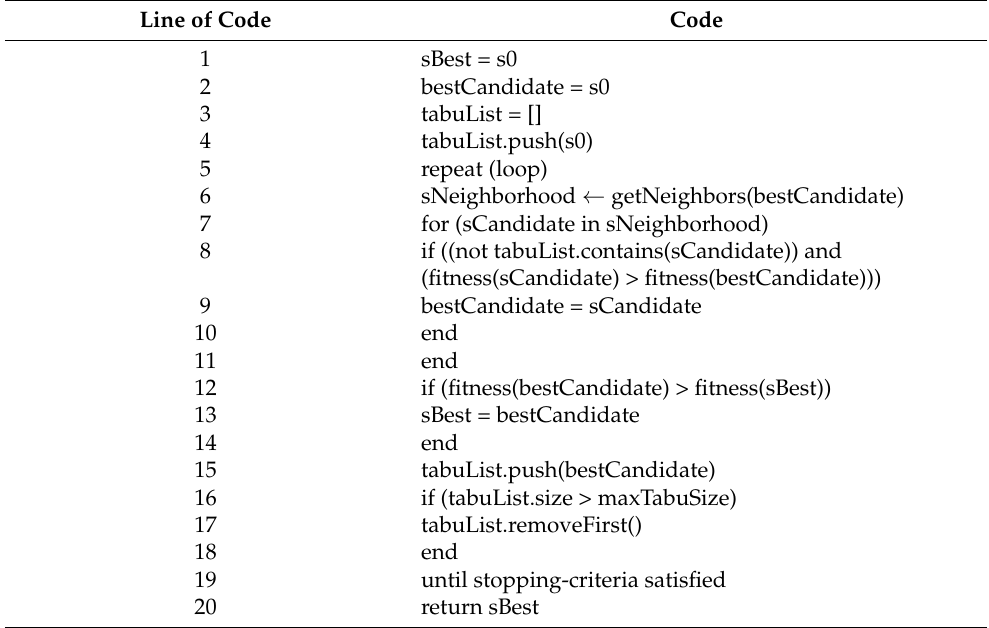
Table 3. Simplified tabu search